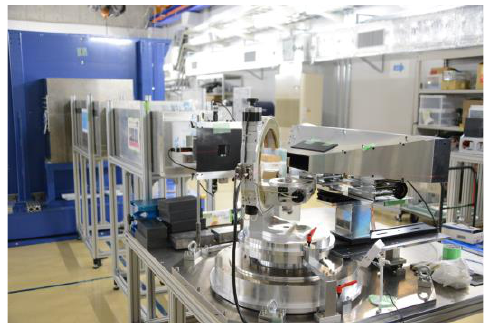
Fig.5 Diffractometer of RANS without shielding